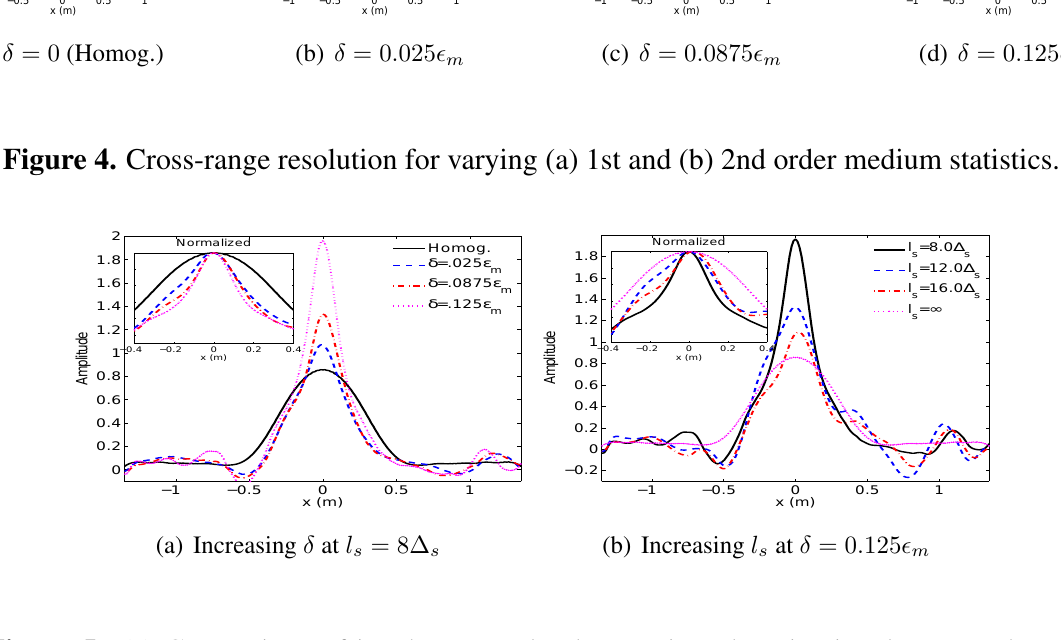
Figure 5. (a) Comparison of incoherent and coherent time-domain signals. Note that al- though (b) the magnitudes of the frequency domain representation of both signals are same, (c) the phases are not. Incoherency comes from the oscillations in the phase arising from the SVD or EVD